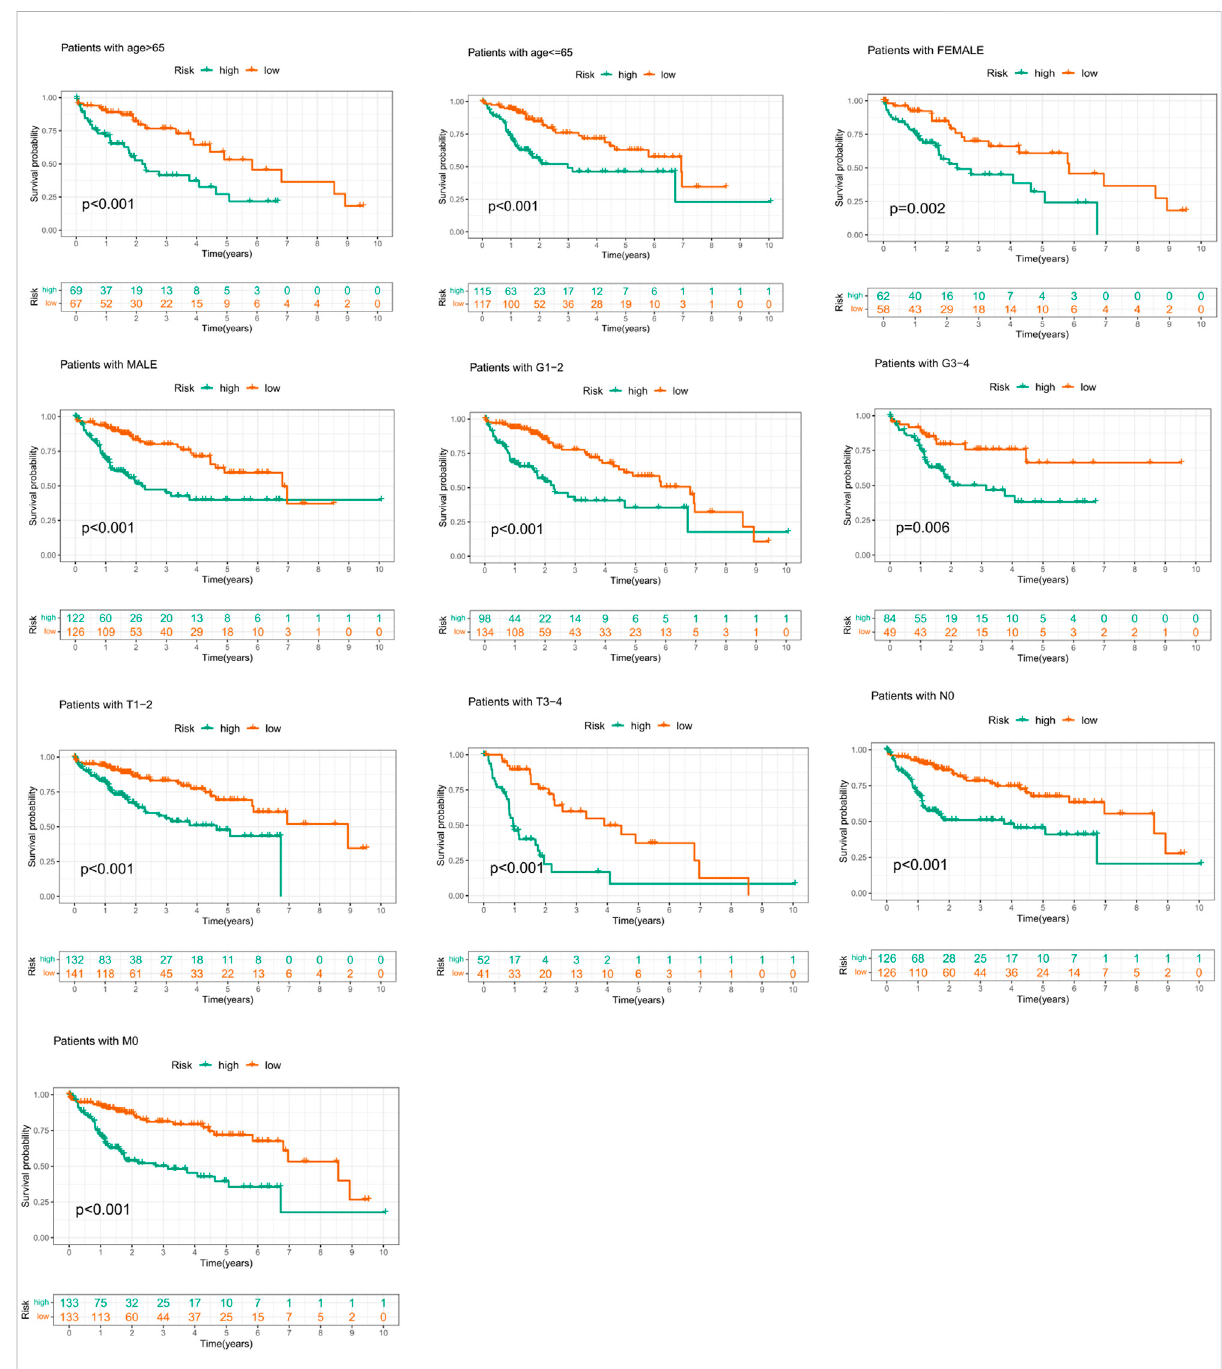
FIGURE 6 Comparison of survival of patients by risk signature score within each